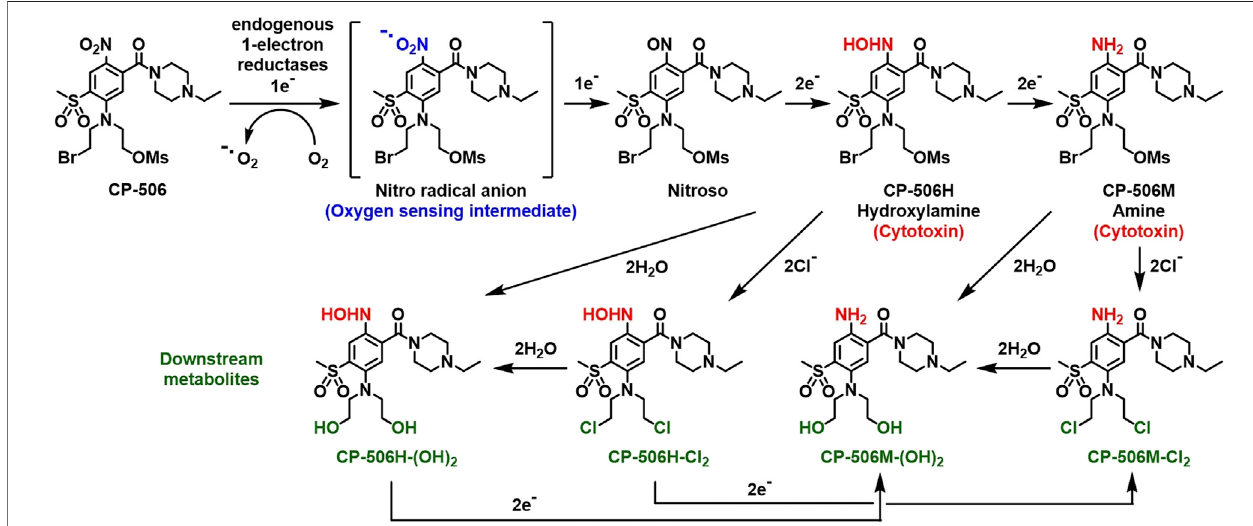
FIGURE 2 | Schematic representation of the activation sequence for CP-506. CP-506 is metabolised by endogenous one-electron reductases into a nitro radical anion that is readily back-oxidised in the presence of molecular oxygen. Under hypoxia, the nitro radical anion is further metabolised to its corresponding hydroxylamine (CP-506H) and amine (CP-506M) metabolites. The major metabolites are highly reactive. Each arm of the bromomesylate mustard can react with chloride ions and/or undergo aqueous hydrolysis providing the major observed downstream metabolites, CP-506H-Cl 2 , CP-506H-(OH) 2 , CP-506M-Cl 2 , and CP-506M-(OH) 2